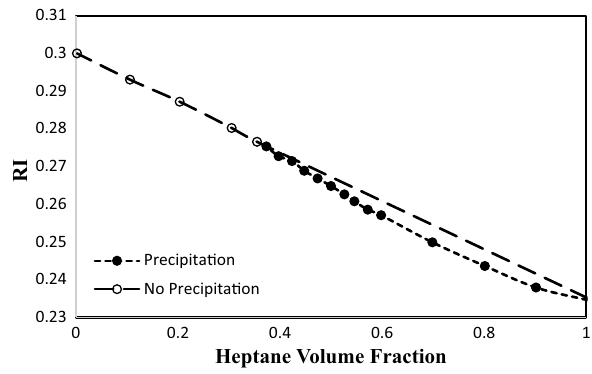
Fig. 14 RI of CLA oil and heptane mixture versus volume fraction of heptane (Wattana et al. 2003)